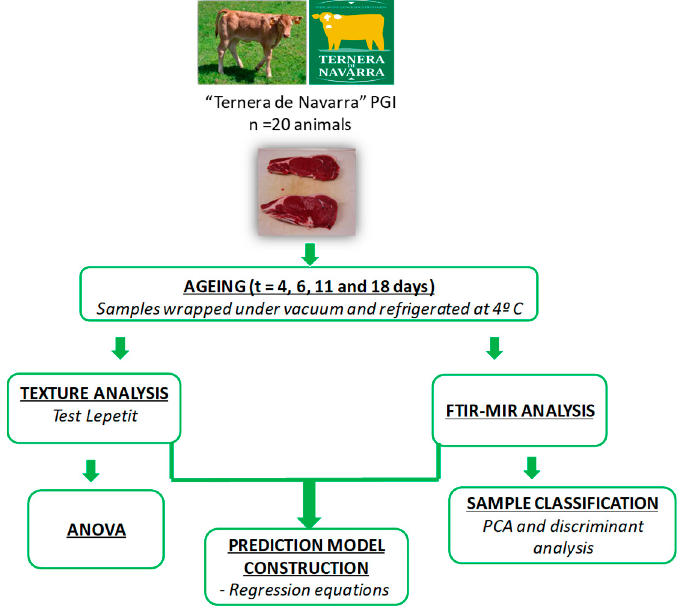
Figure 1. Scheme of the experimental design.